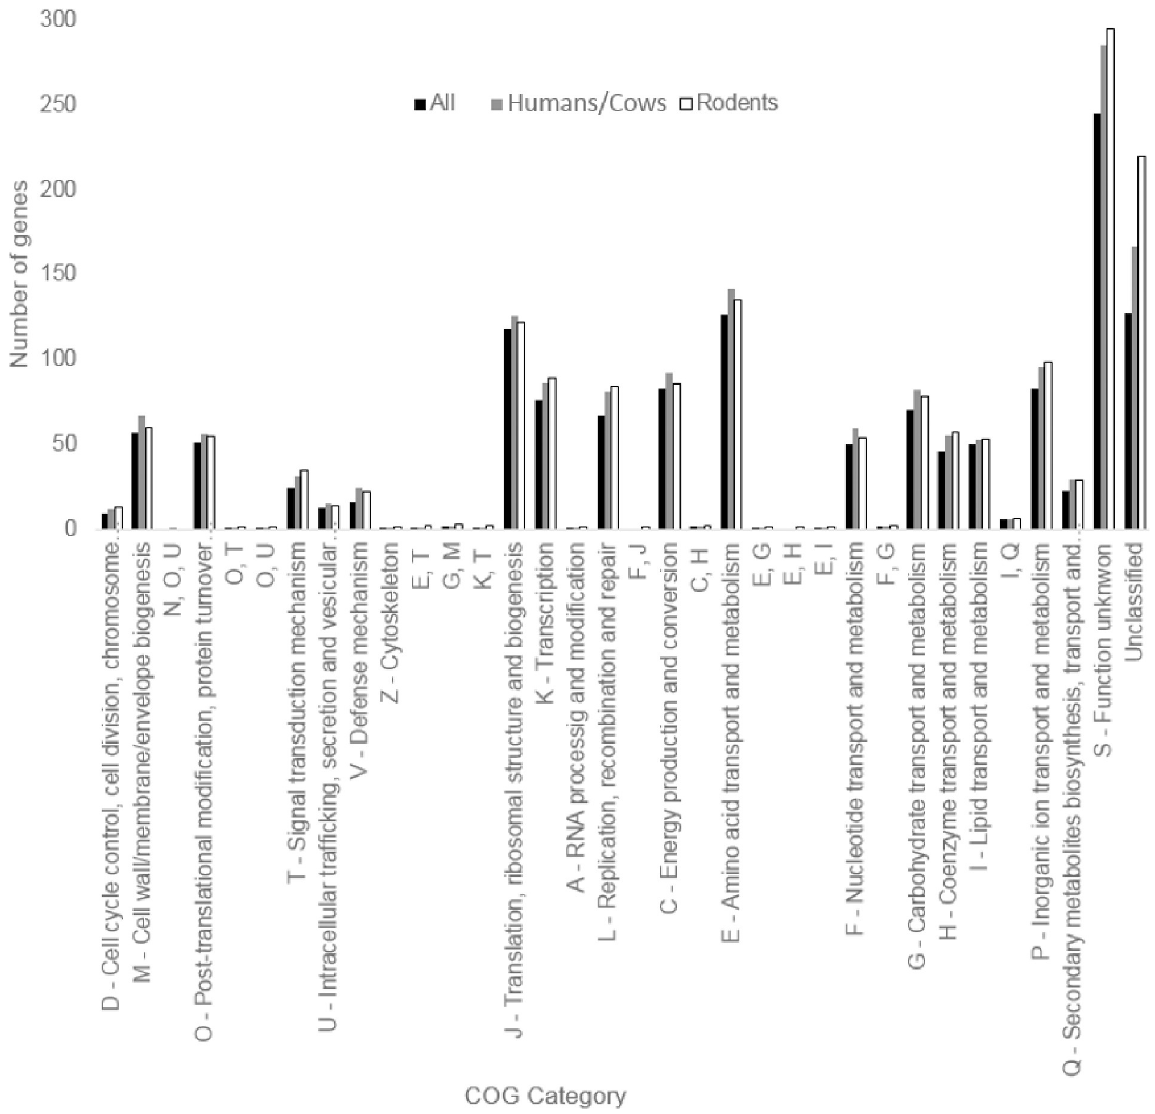
Fig 9. Number of genes classified in various COG categories for C . bovis isolates obtained from humans and cows vs. isolates obtained from rodents.